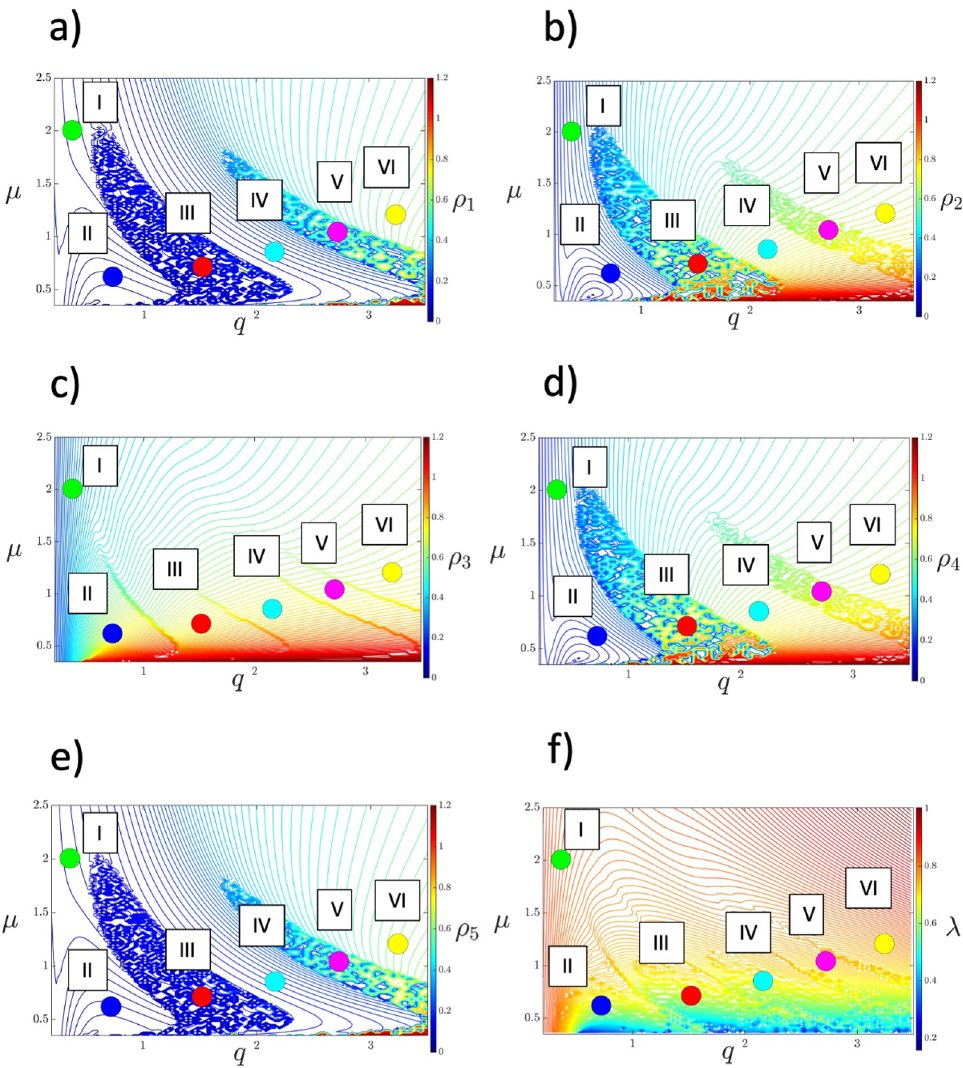
Figure 4 . The landscape of timecrystalline Q-balls in terms of ( q; (cid:22) ). The Panels a)-e) show the landscape for the (cid:12)ve order parameters (cid:26) 1 : : : (cid:26) 5 , respectively. In each panel the (cid:26) k of the six energy minima shown in (cid:12)gures 3 are identi(cid:12)ed. The roughness of the landscape is due to a k ! 6 (cid:0) k symmetry: a timecrystalline Q-ball corresponds to a double degenerate ground state energy and the roughness describes how at each point the landscape is constructed from a randomly chosen initial con(cid:12)guration, to display the presence of double degeneracy. Panel f) then shows the j (cid:21) cr j values, evaluated from